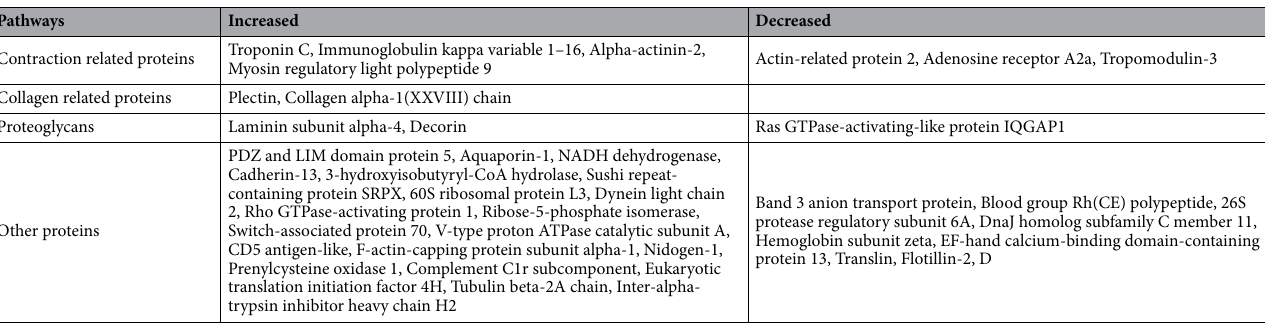
Table 4. Changed proteins classified by